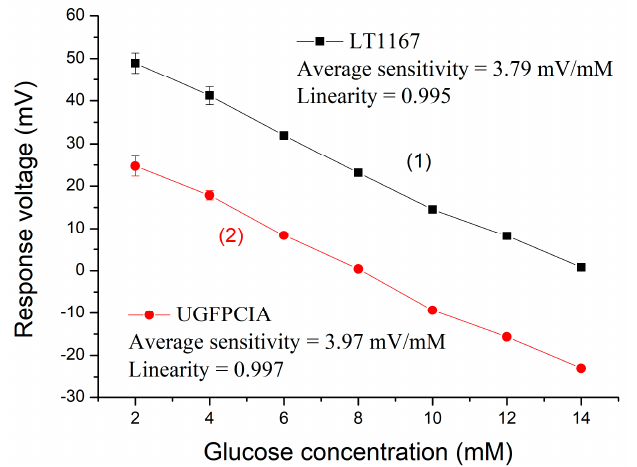
Figure 3. Average sensitivities of the CZO sensor.